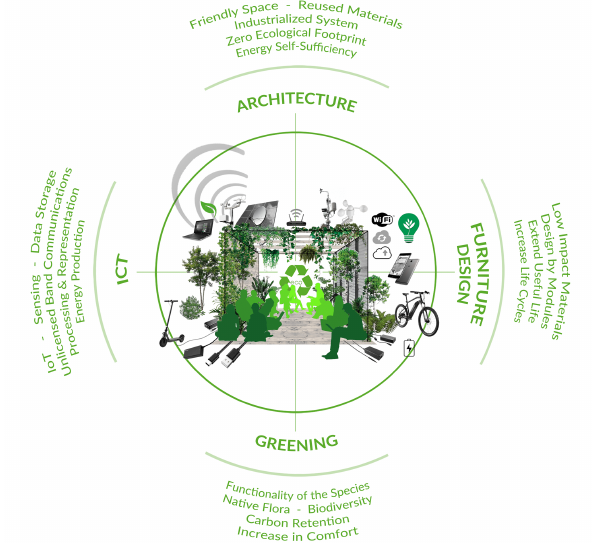
Figure 1. Smart tree multidisciplinary concept